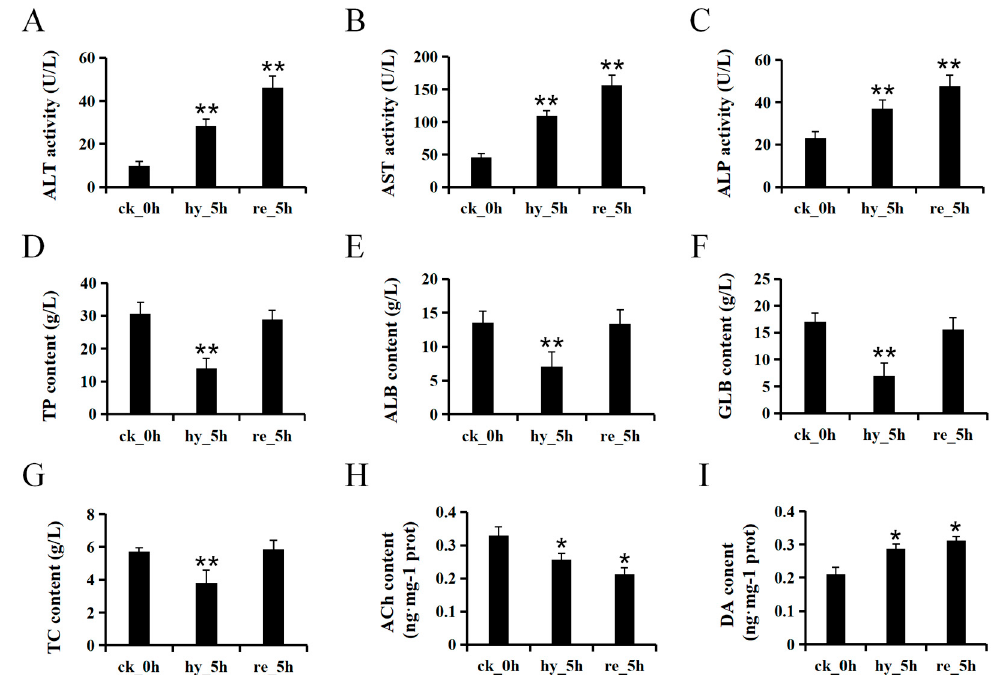
Figure 1. Alterations to biochemical indices related to the functions of the liver and brain in juvenile silver carp treated with hypoxia–reoxygenation. Values are expressed as the mean ± SD. The * p < 0.05 and ** p < 0.01 indicate significant differences compared with the control group. ck_0h: control group; hy_5h: hypoxia group; re_5h: reoxygenation group: ( A – C ) the serum ALT, AST, and ALP, activities; ( D – G ) the serum TP, ALB, GLB, and TC contents; ( H , I ) the brain Ach and DA contents. ALP, alkaline phosphatase; AST, glutamic-oxalacetic transaminase; ALT, glutamic-pyruvic transaminase; TC, total cholesterol; GLB, globulin; ALB, albumin; TP, total protein; Ach, acetylcholine; DA, dopamine.